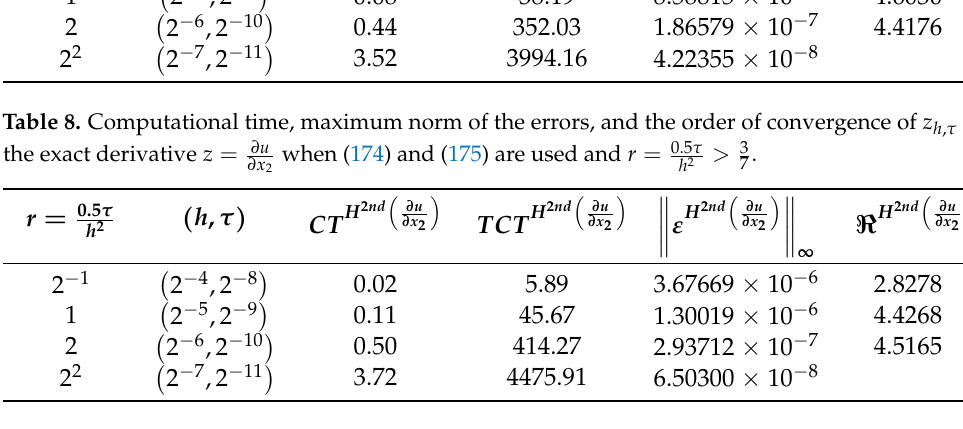
Table 7. Computational time, maximum norm of the errors, and the order of convergence of v h , τ to when (172) and (173) are used and r = 0.5 τ the exact derivative v = ∂ u ∂ x 1 r = 0.5 τ h 2